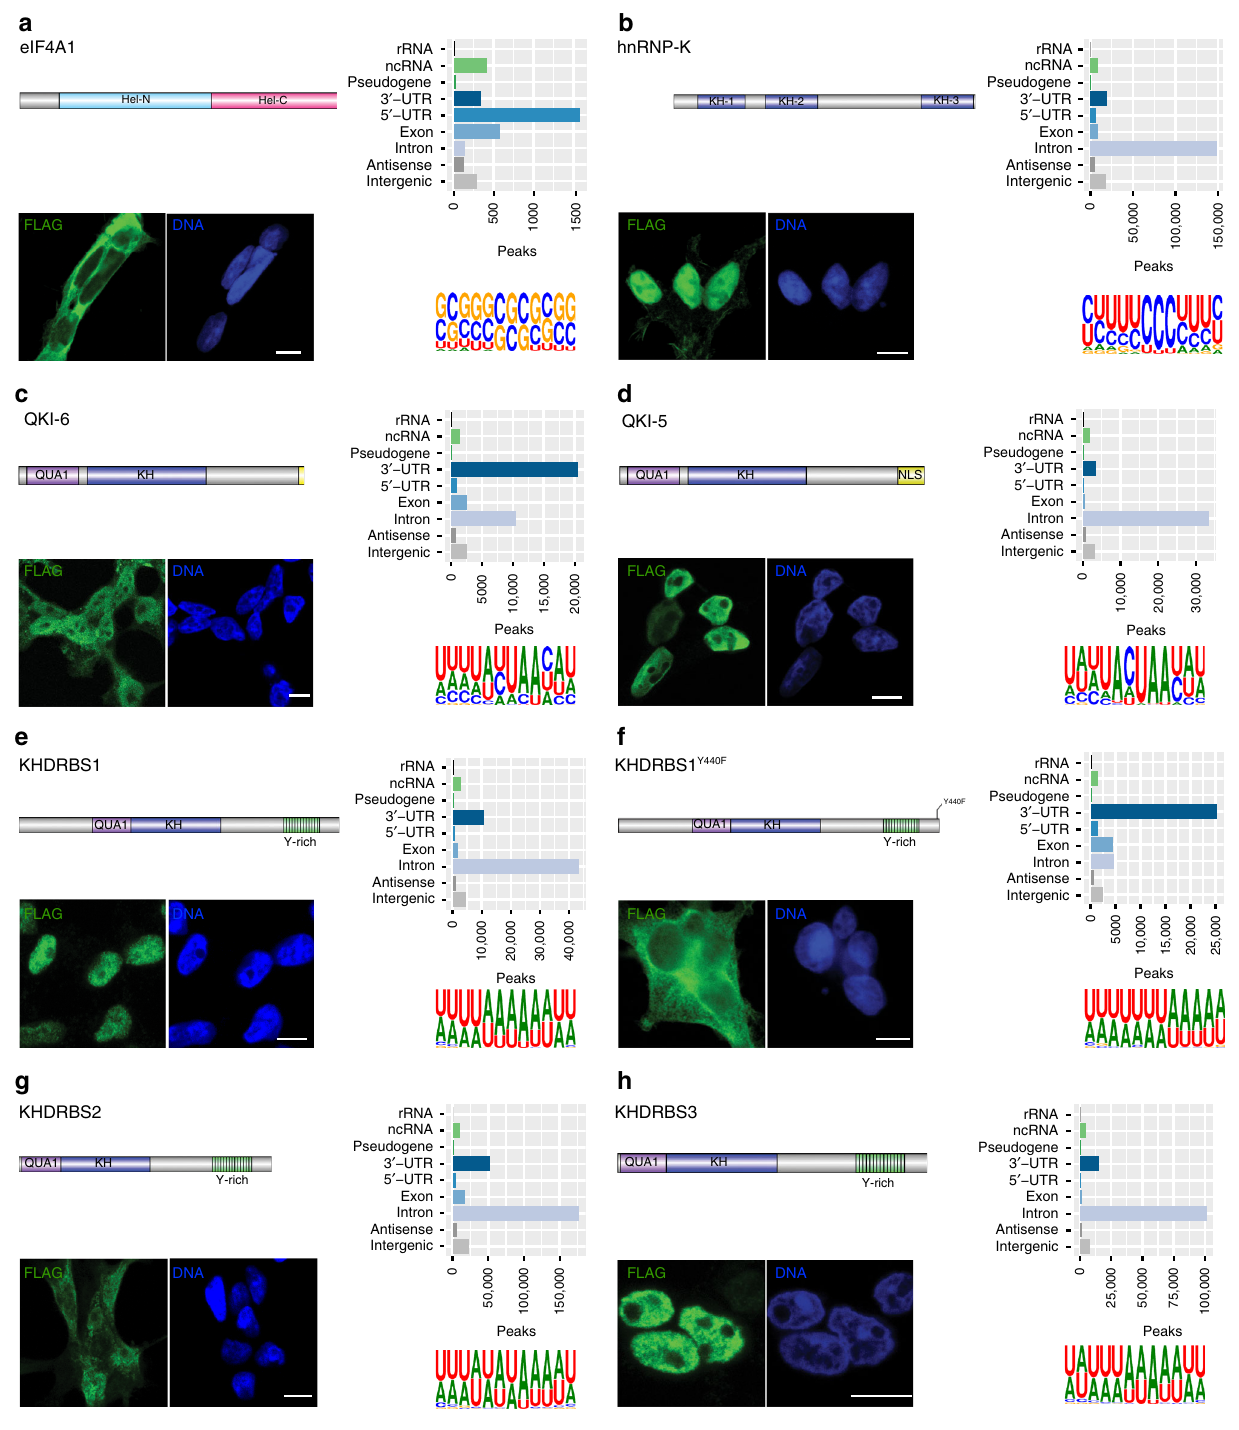
Fig. 3 Cellular localization of RBPs do not change their preferred RNA motif. Cellular localization of FLAG-tagged RBPs (scale bars represent 10 µ m); number of JAMM peaks located on genomic target classes with each peak assigned once to the category with highest priority corresponding to the order rRNA, ncRNA, pseudogene, 3 ’ -UTR, 5 ’ -UTR, exon, intron, antisense, intergenic (see Supplementary Table 6 for the counts of peaks on genomic targets); and Sequence motifs determined by GraphProt 36 for human proteins a EIF4A1, b hnRNPK, c QKI-6, d QKI-5, e KHDRBS1, f KHDRBS1 Y440F , g KHDRBS2, and h